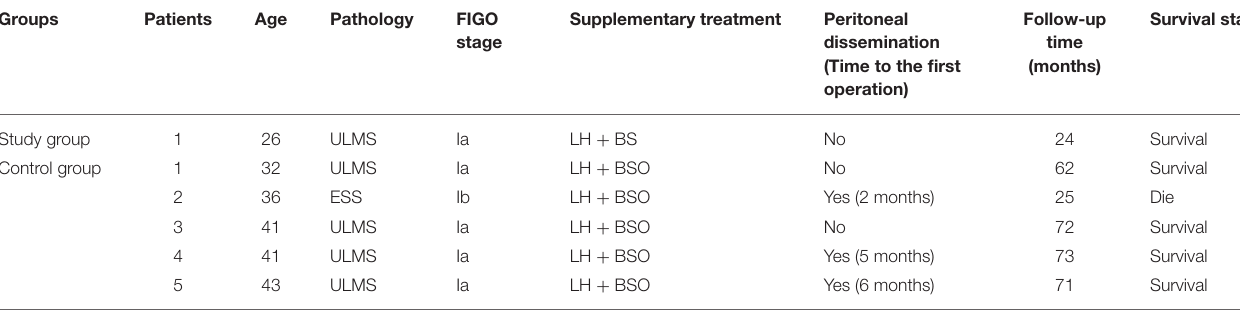
TABLE 5 | Patients with unexpected uterine sarcoma during laparoscopic surgeries for uterine leiomyoma. Groups